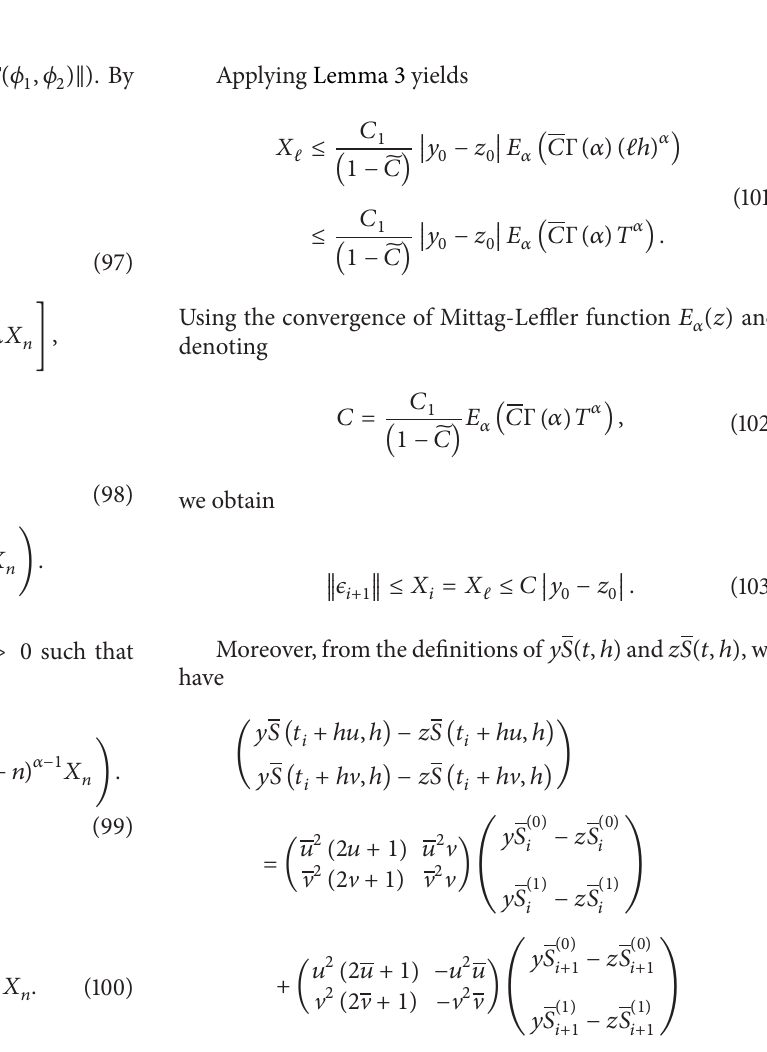
Figure 4: The error between the numerical solutions and the exact solution of the problem (109); ℎ = 0.05 , 𝛼 = 0.000001 .